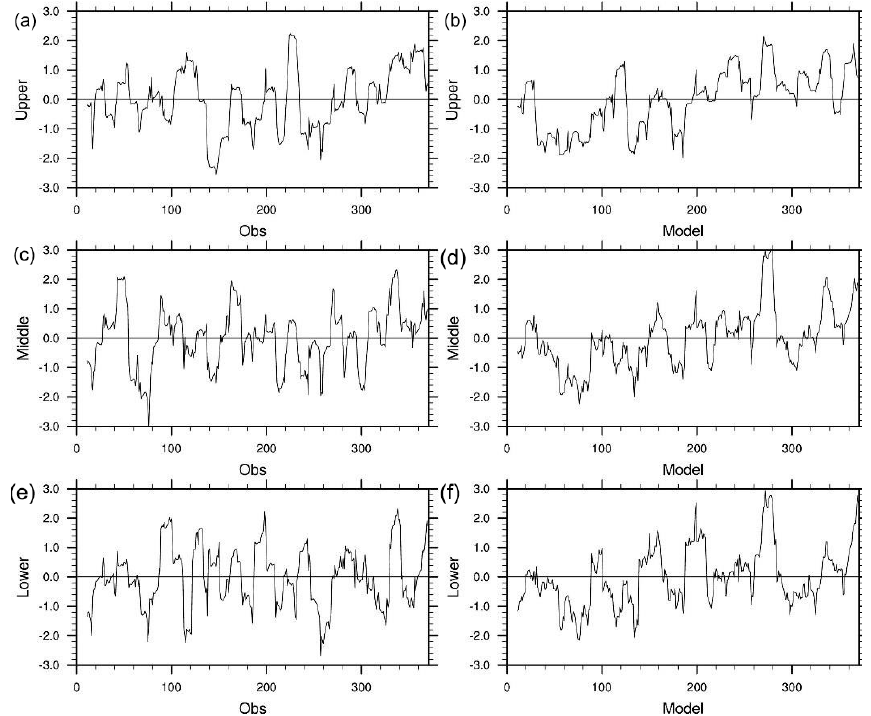
Figure 5. The standardized precipitation index (SPI) for the 12-month timescale over the analysis period. The left panels (a, c, e) and right panels (b, d, f) are observation and simulation. From top to bottom are the upper (a, b) , middle (c, d) , and lower (e, f) basins. The horizontal number is the month from the beginning of the analysis period.